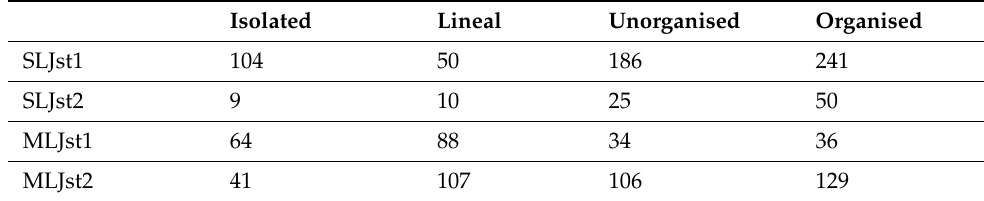
Table 2. Distribution of convective modes according to the number of jumps (single or multiple) and the level of the LJ (1 or